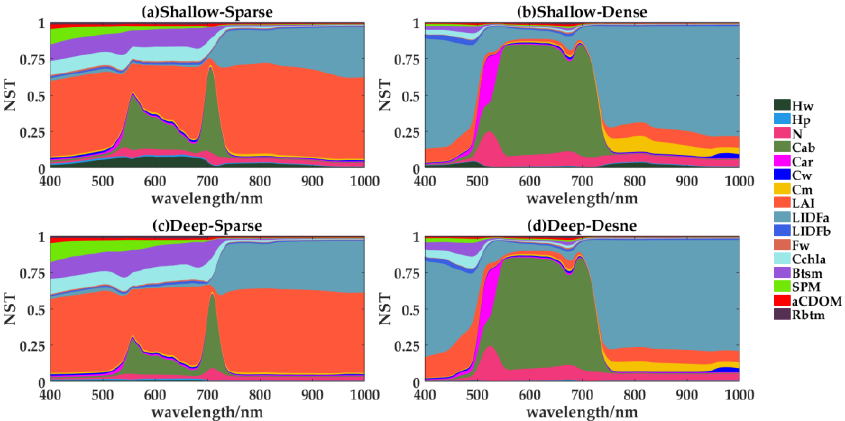
Figure 3. The cumulative plot of normalized total order sensitivity ( NST ) for emergent vegetation in four different cases. ( a ), ( b ), ( c ), ( d ) represent the cases of shallow-sparse, shallow-dense, deep-sparse and deep-dense, respectively. The area enclosed by the curve and the horizontal axis (the first parameter in the list, Hw), and between the curves (except Hw) represents the value of NST .